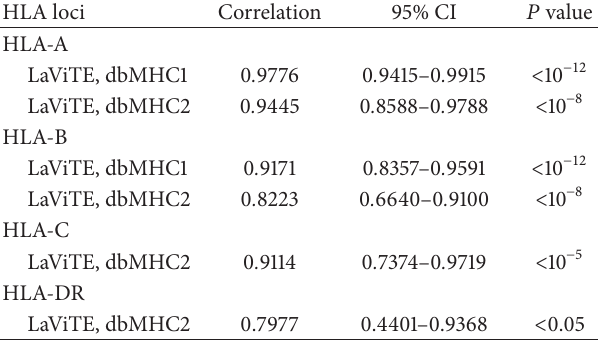
Table 2: Correlations between the observed allelic frequencies in the LaViTE cohort and two other Brazilian datasets deposited in the dbMHC database of the NCBI, dbMHC1 (Minas Gerais, Brazil), and dbMHC2 (S˜ao Paulo, Brazil).